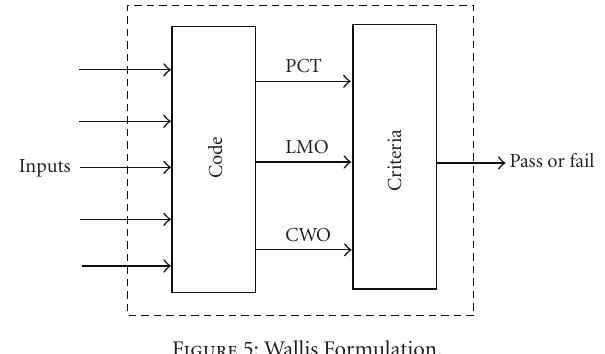
Figure 5: Wallis